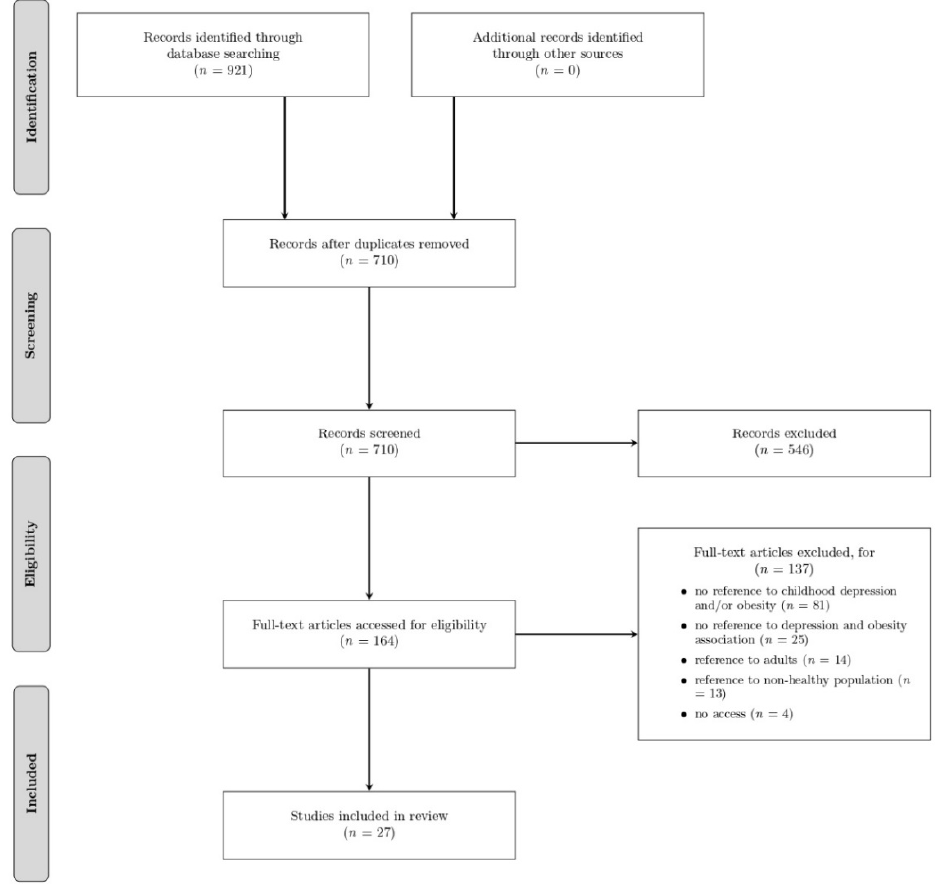
Figure 1. PRISMA diagram of search strategy.